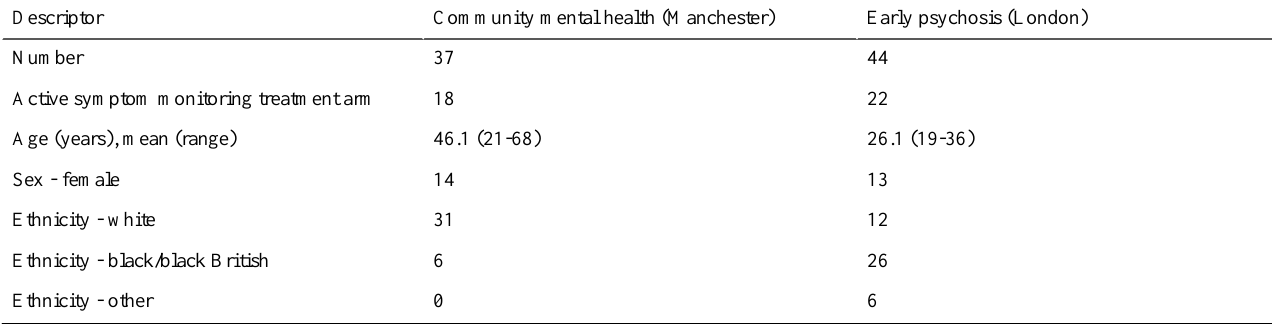
Table 2. Demographic data by